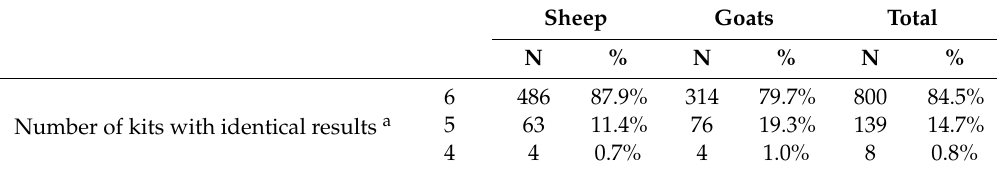
Table 1. Agreement among serological test results in order to define the small ruminant lentivirus (SRLV) infection